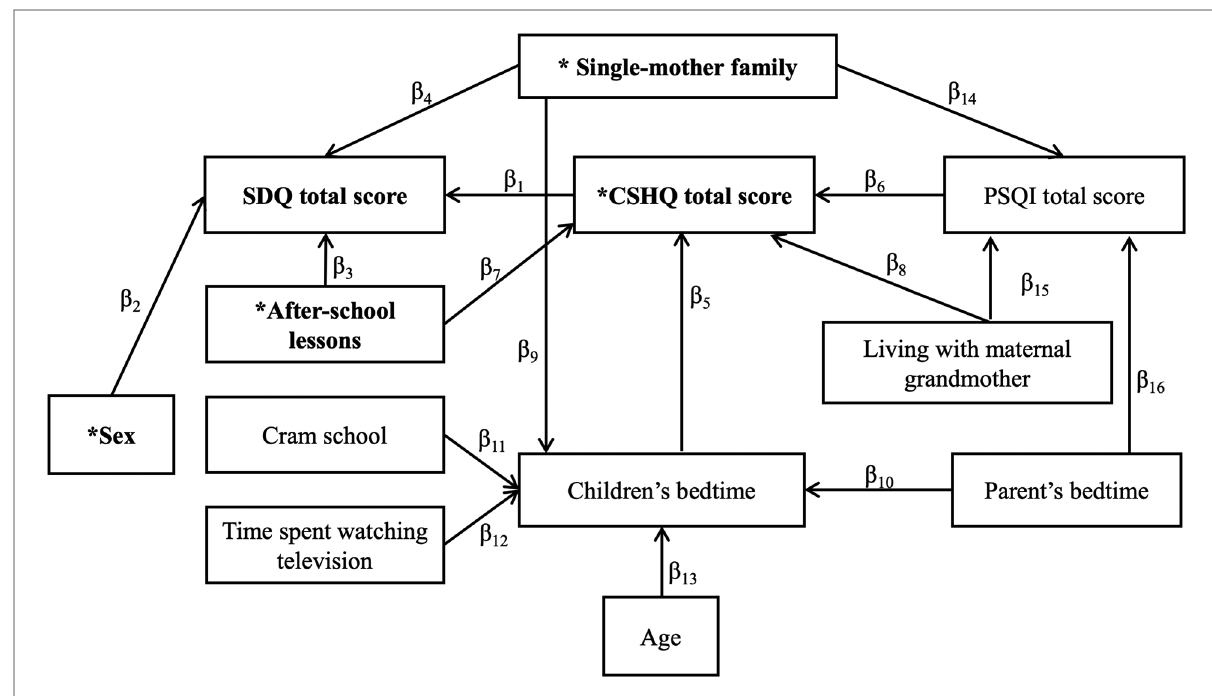
FIGURE 2 Path diagram. Path diagram of factors that affect the SDQ total score. *The four factors that had a direct effect on the SDQ total score. SDQ, Strengths and Dif fi culties Questionnaire; CSHQ, Children ’ s Sleep Habits Questionnaire; PSQI, Pittsburgh Sleep Quality